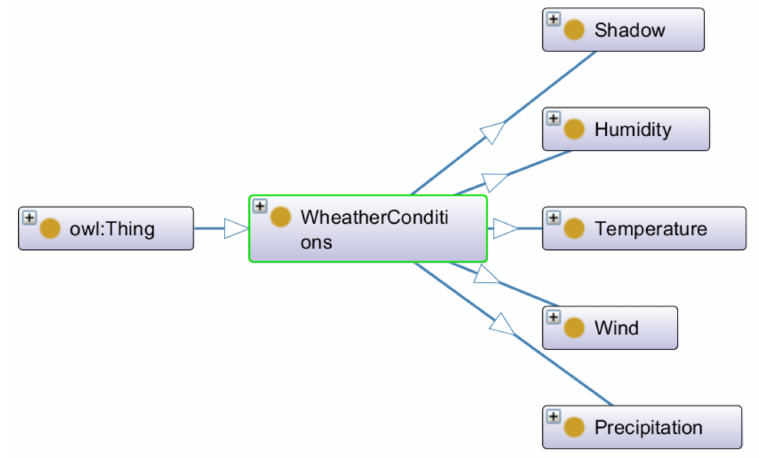
Figure 12. Second ontology defined for the Weather_conditions module (Protégé